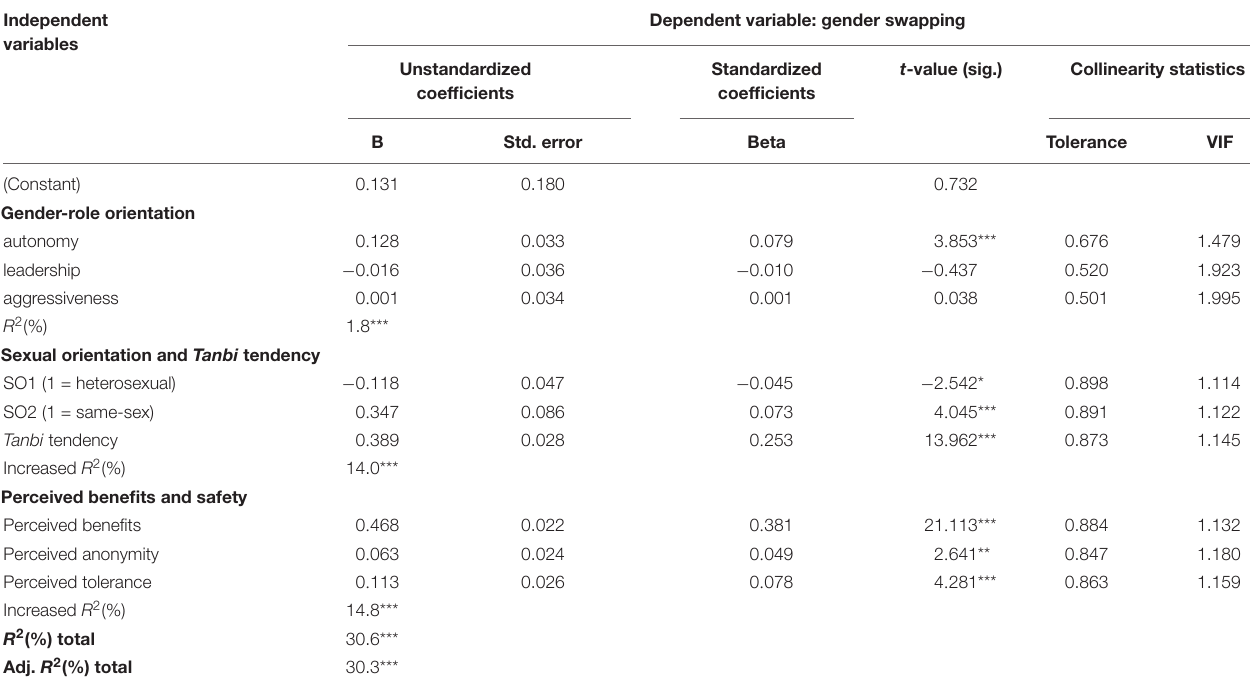
TABLE 1 | Multivariate regression analysis for predicting gender swapping. Independent